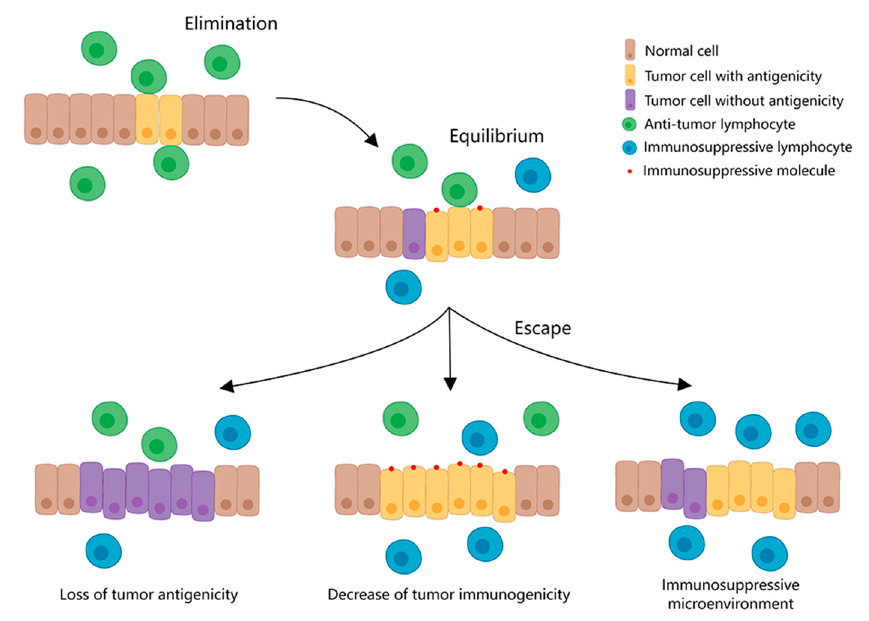
Figure 1. Immune escape mechanism of tumors. Along with tumor growth, the immune system develops immune tolerance to tumor cells due to weakened antigenicity of tumor cells, reduced responsiveness to immune killing mechanisms, and expression of immunosuppressive